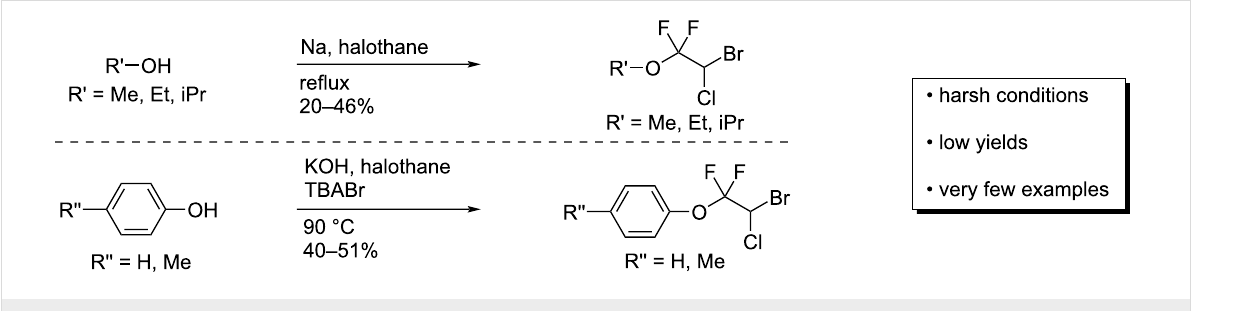
Scheme 2: The previous work reported by Yagupol’skii et